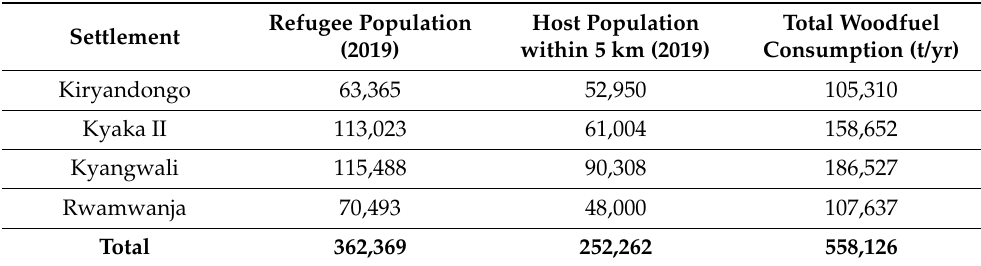
Table 7. Estimated woodfuel consumption in the target refugee settlements and 5 km buffer in western and southwestern Uganda.